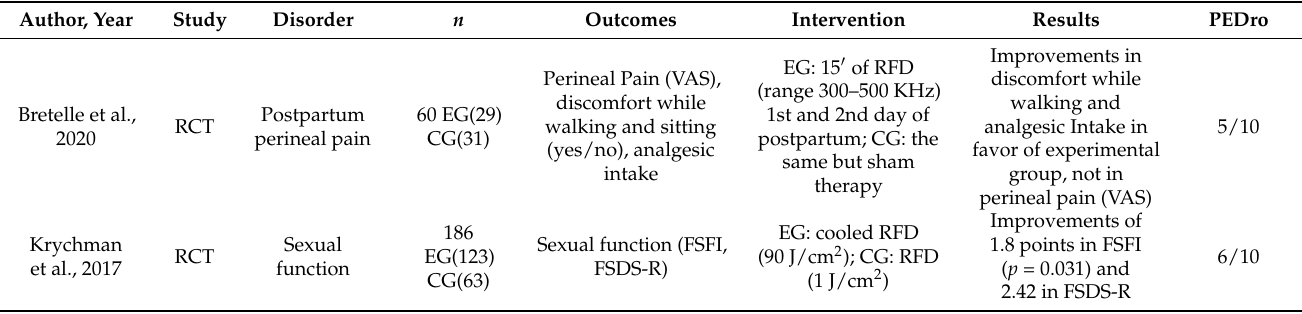
Table 2. Summary of the randomized controlled trials selected.